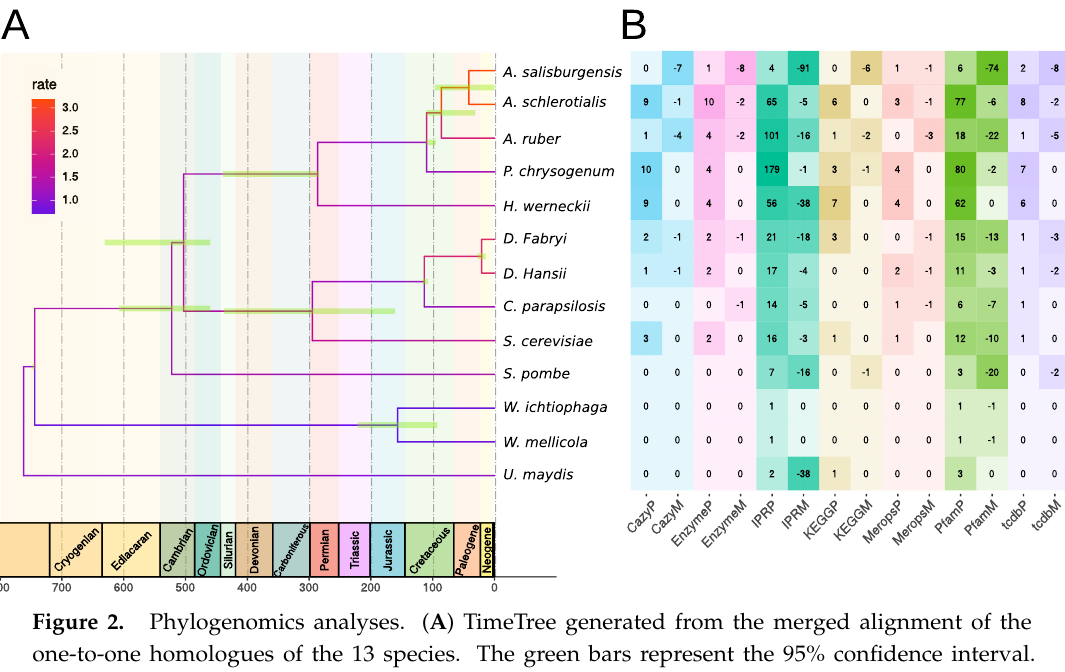
Figure 2. Phylogenomics analyses. ( A ) TimeTree generated from the merged alignment of the one-to-one homologues of the 13 species. The green bars represent the 95% confidence interval. Geologic periods are color-coded and indicated at the bottom of the tree. Evolutionary rate is color encoded. ( B ) CAFE analysis of the expansion and contraction of the annotation elements of KEGG, CAZY, TCDB, Enzyme, and MEROPSfor the 13 species. The suffixes Mand Pafter the annotation categories stand for contraction and expansion,